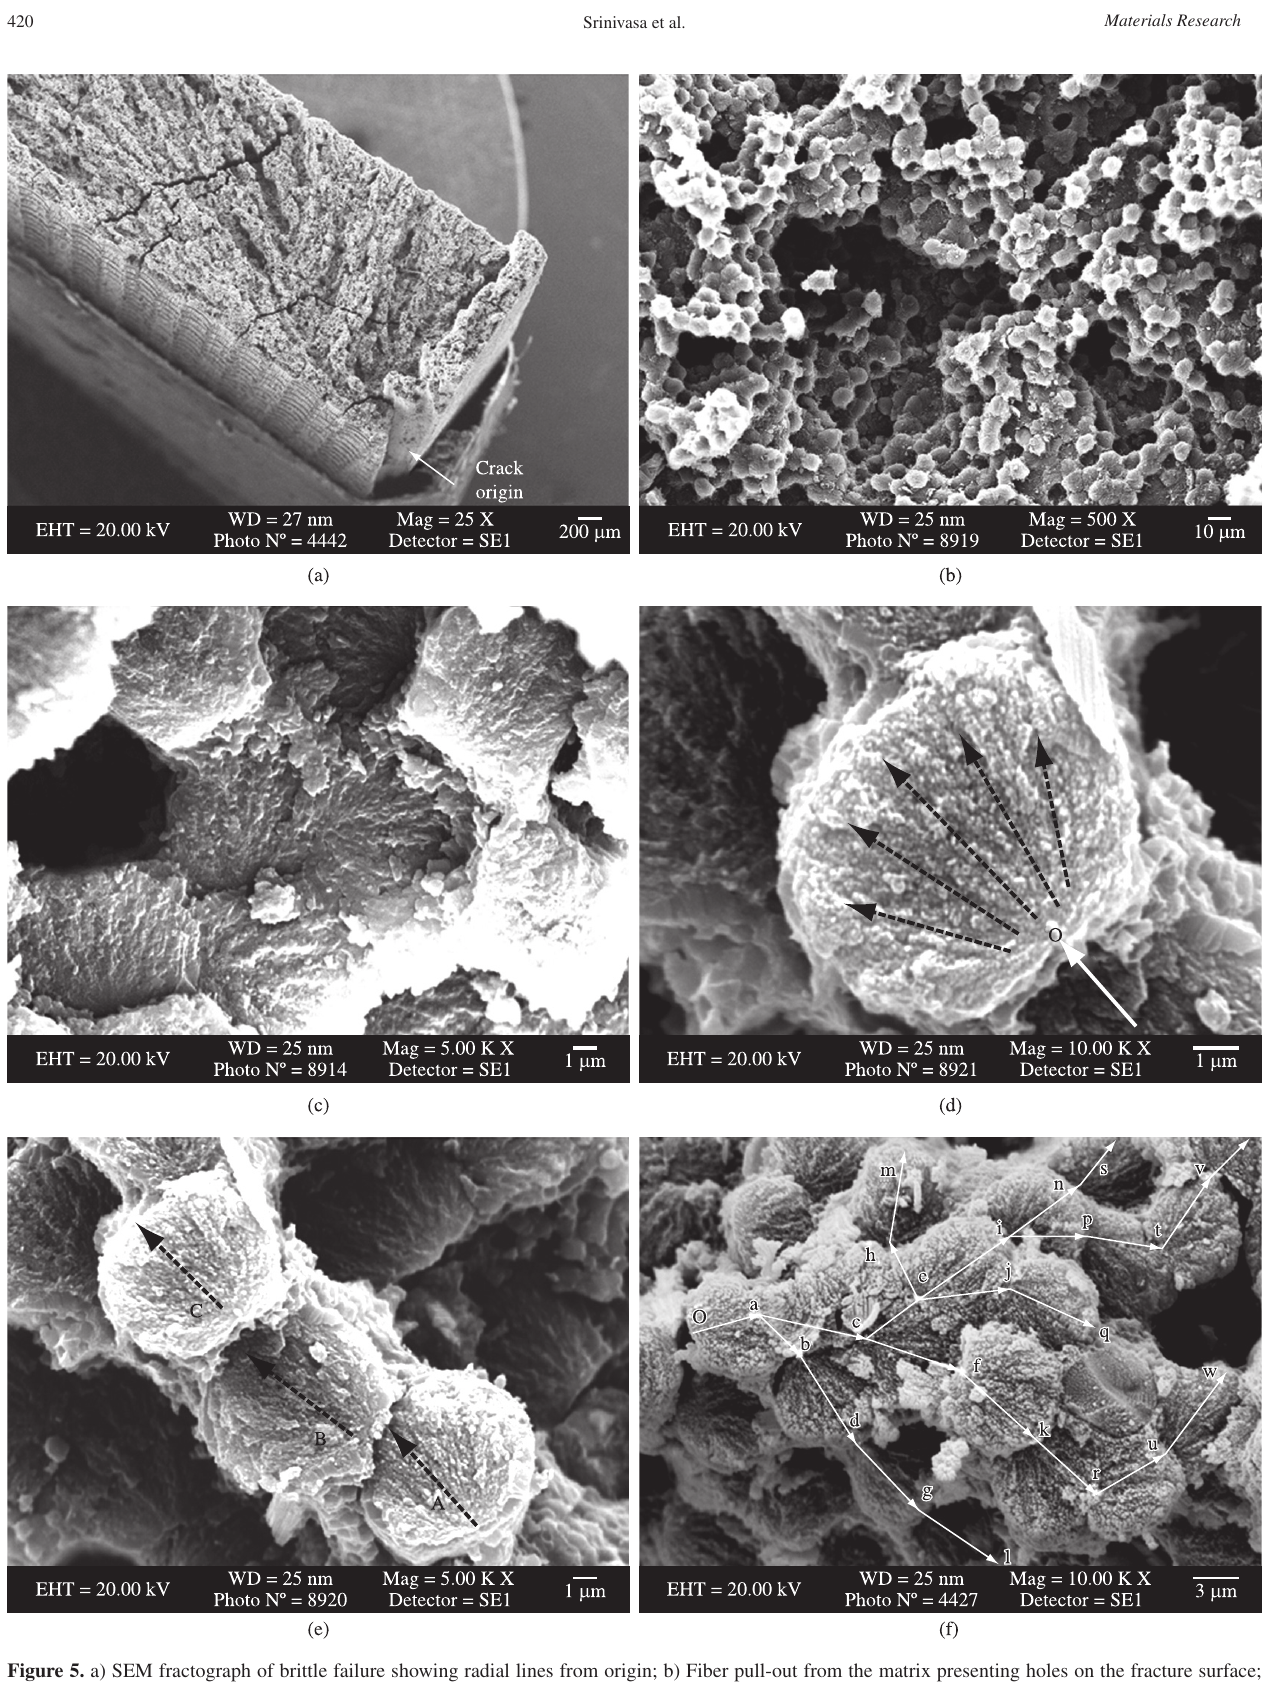
Figure 5. a) SEM fractograph of brittle failure showing radial lines from origin; b) Fiber pull-out from the matrix presenting holes on the fracture surface; c) Radial Marks on the Fiber Fracture Surface at High Magnification; d) Initiation of radial marks & propagation direction on fiber fracture surface; e) Fiber radials indicate the crack propagation direction (Arrows denoting local crack propagation direction); and f) SEM fractograph referring to the local crack propagation on individual